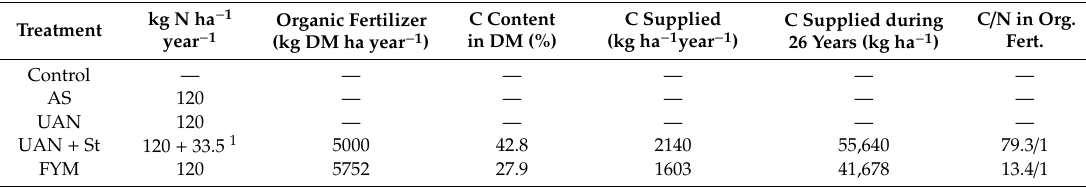
Table 5. Fertilizing design of the experiment; AS—ammonium sulfate, UAN—urea ammonium nitrate, UAN + st–urea ammonium nitrate + straw, FYM–farmyard manure, DM—dry matter, C—carbon,